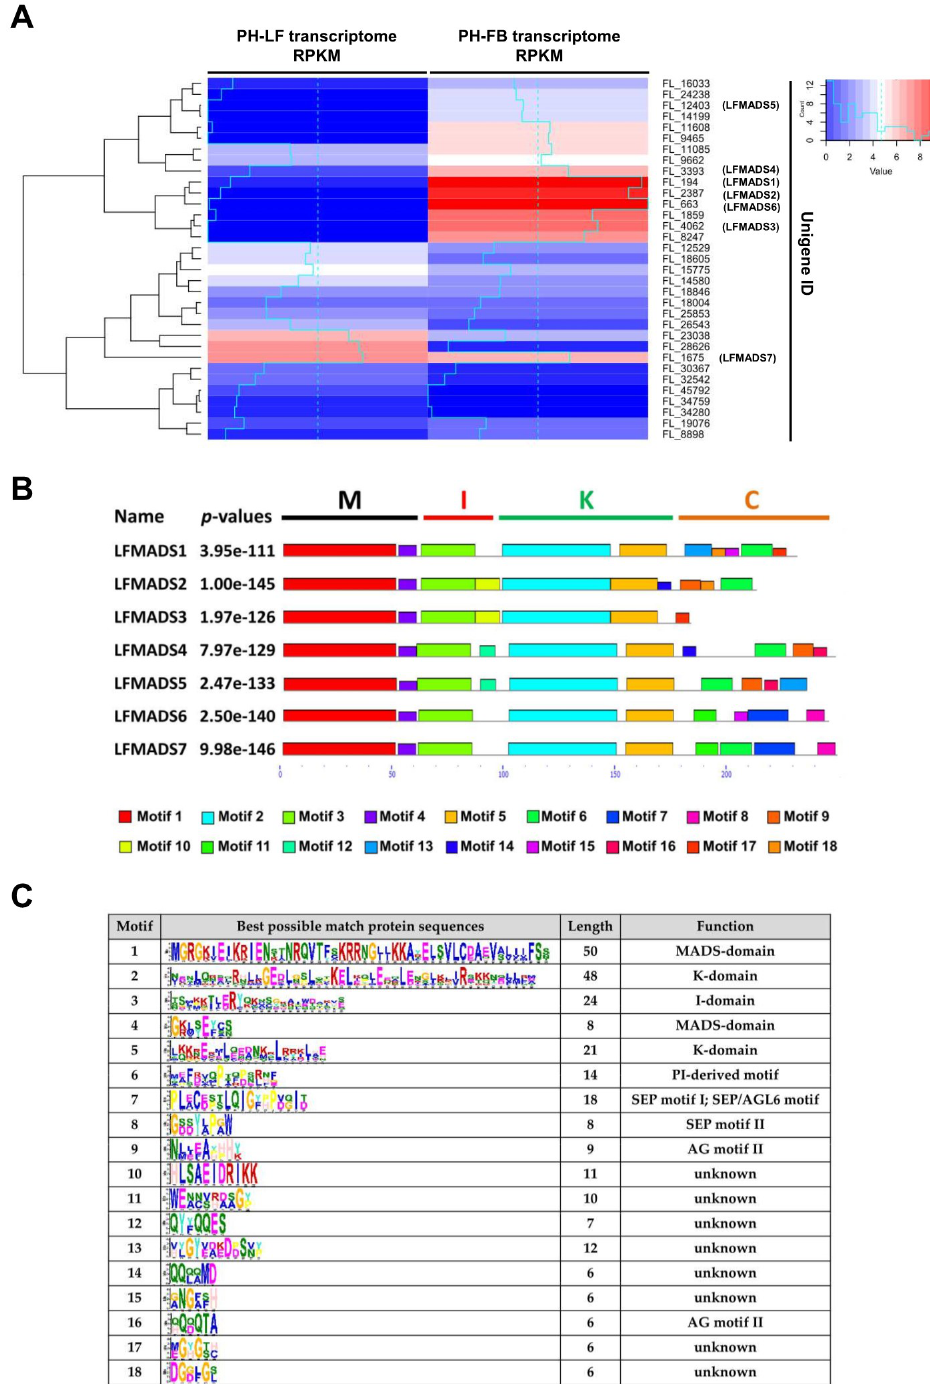
Figure 2. The expression profiles and motifs identified using online MEME tools for LFMADS1–7. ( A ) The expression patterns of unigenes homologous with MADS-box genes in Arabidopsis identified from PH-FB and PH-LF transcriptome data. The values of log 2 [RPKM] represent the expression level for each unigene in floral buds and mature leaves, respectively. From blue to red colors in the map indicate the expression levels from low to high. ( B ) The motif location and combined p -value of LFMADS1–7 are shown on the left and denoted by rectangles with different colors. ( C ) Possible amino acid sequences and functions of Motifs 1–18 identified using MEME tools for LFMADSs.